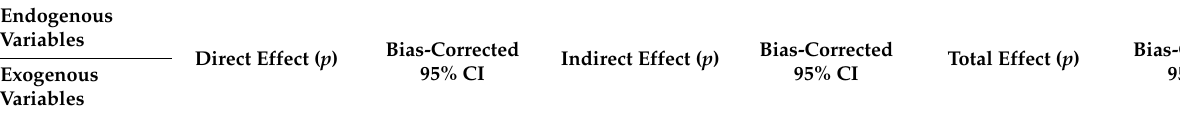
Table 4. The model standardized direct, indirect, and total effect (N =